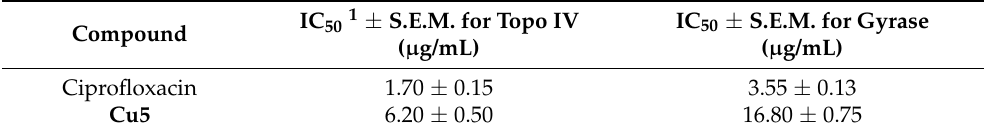
Table 7. Inhibition of catalytic activities of S. aureus topoisomerases.